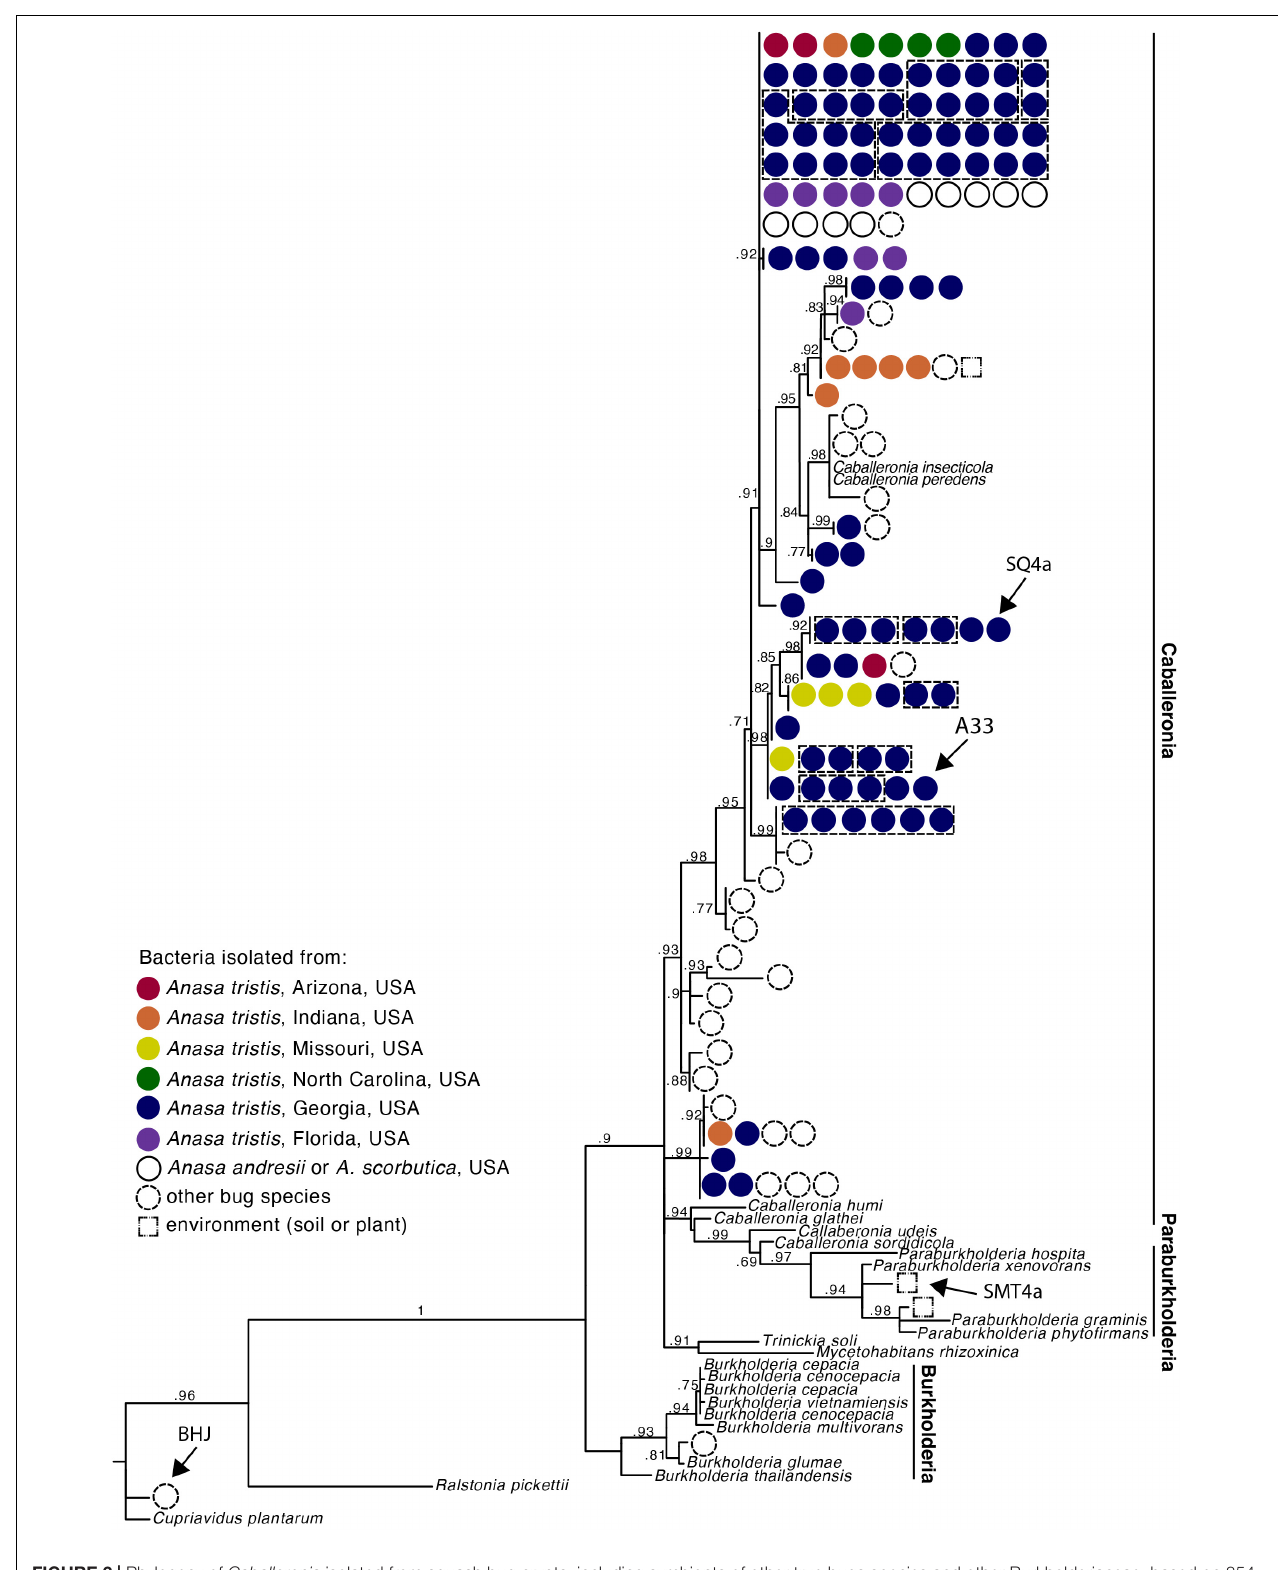
FIGURE 2 | Phylogeny of Caballeronia isolated from squash bug crypts, including symbionts of other true bugs species and other Burkholderiaceae, based on 854 base pair alignment of 16s rRNA gene sequences. Dashed lines group isolates within a clade that were isolated from the same individual. Detailed taxa information is provided in Supplementary Figure 2 . Arrows point to isolates used for fitness